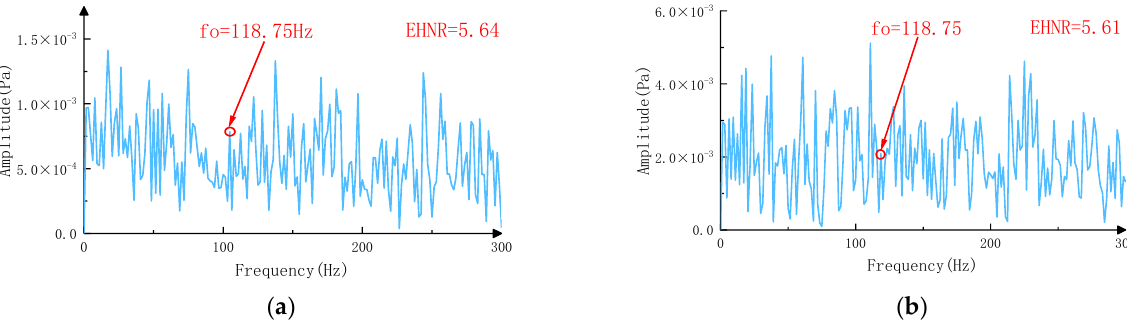
Figure 9. Envelope spectrum after applying ( a ) the RLS-RSSD analysis and ( b ) the parameter-optimized VMD.